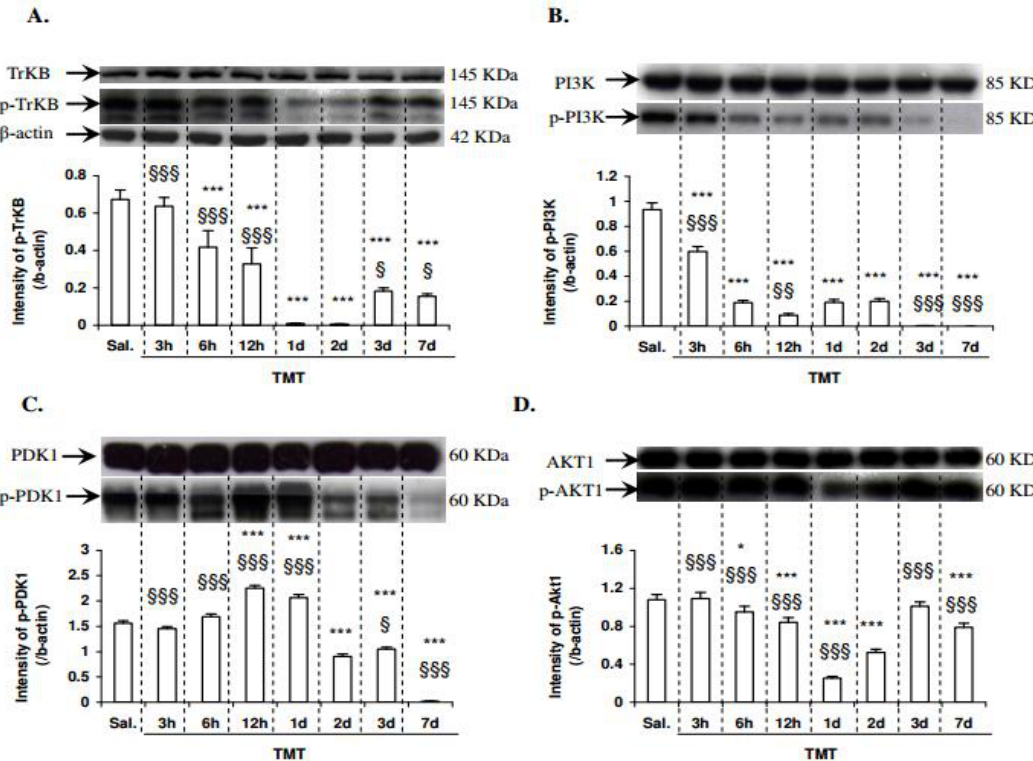
Figure 1. Time-dependent hippocampal changes in TrkB receptors, phospho-TrkA/B receptors (Figure 1A); in PI3K and phospho-PI3K (Figure 1B); in PDK1 and phospho-PDK1 (Figure 1C); in Akt and phospho-Akt (Figure 1D) of TMT-treated mice. Reductions in phospho-TrkA/B but not total TrkB were detected 3 h, 6 h, 12 h, 2 d, 3 d, and 7 d after TMT treatment. The reductions in phospho-PI3K, phospho-PDK1, and phospho-Akt were also detected time dependently. Each value is expressed as the mean±SEM of six mice. * P <0.05, and *** P <0.001 as compared to the saline-treated group; § P <0.05, §§ P <0.01, and §§§ P <0.001 as compared to the 2d after TMT-treated group (The data was analyzed using one-way ANOVA followed by Fisher's PLSD